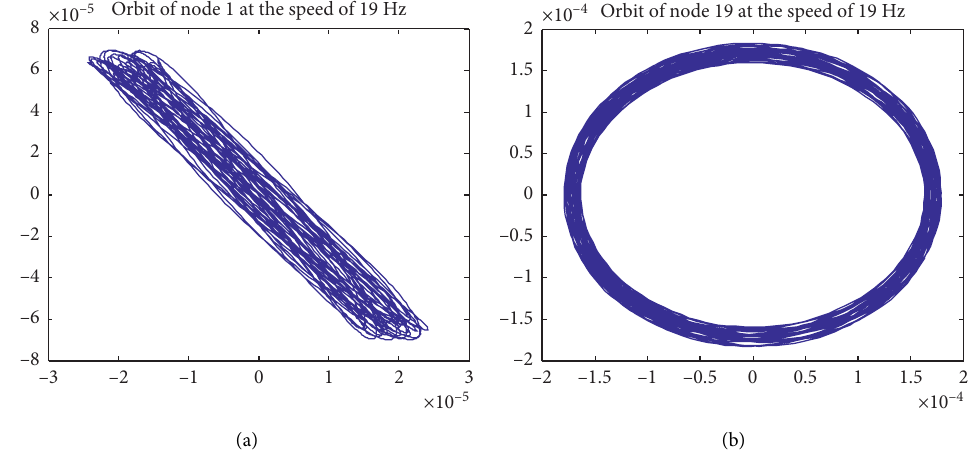
� 19Hz, Δ � 30.4Hz): (a) bearing 1 and (b) bearing 4. 1 2